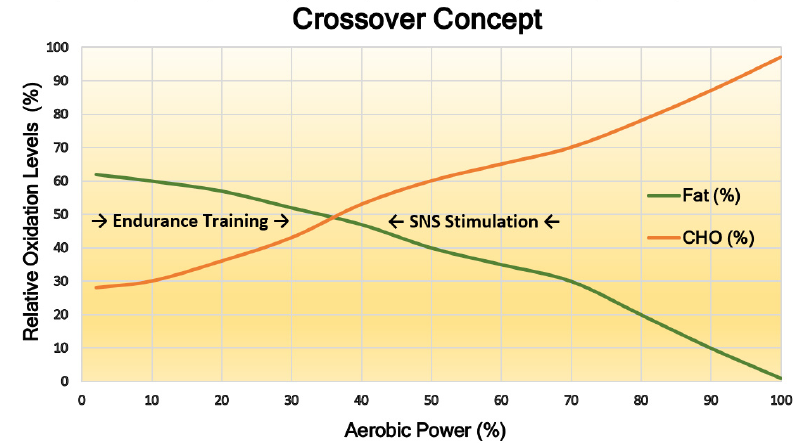
Figure 1. The crossover concept. Adapted from Brooks and Mercier [26]. There is a trade ‐ off between sustainability and power generation in exercise. For ex ‐ ample, anaerobic glycolysis is more catalytically efficient than aerobic respiration, as it produces more ATP per protein mass, but it is less effective in restoring the ATP pool on a large scale compared with FA oxidation (FAO). Nilsson and colleagues [27] identified